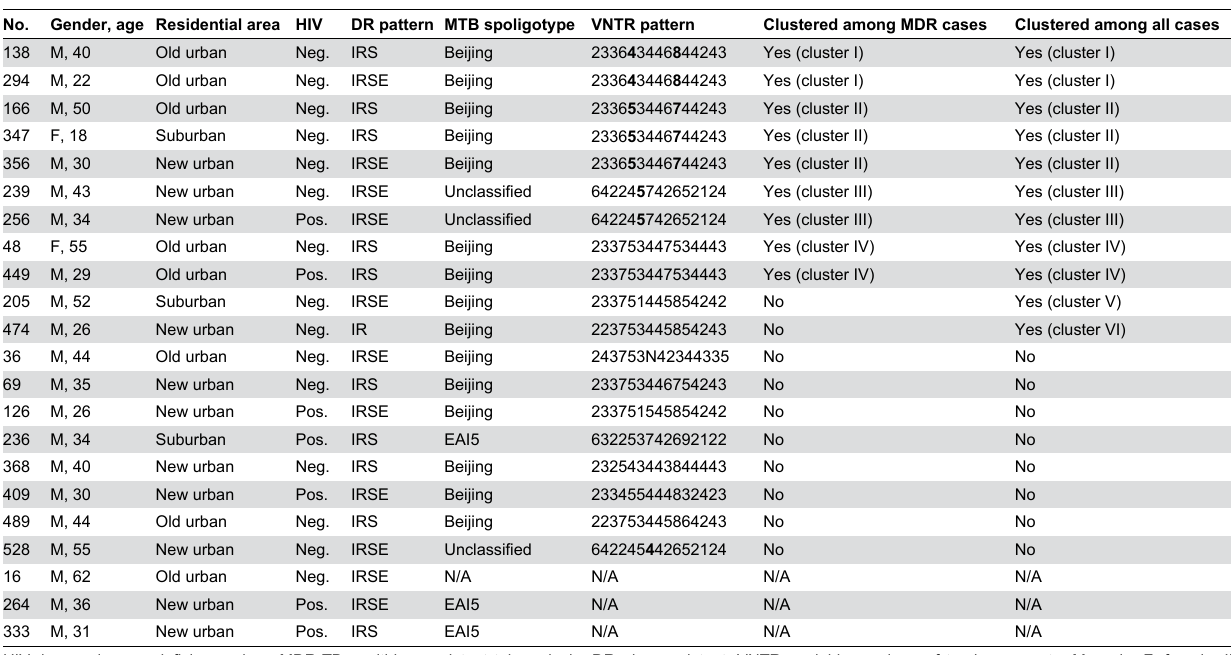
No. Gender, age Residential area HIV